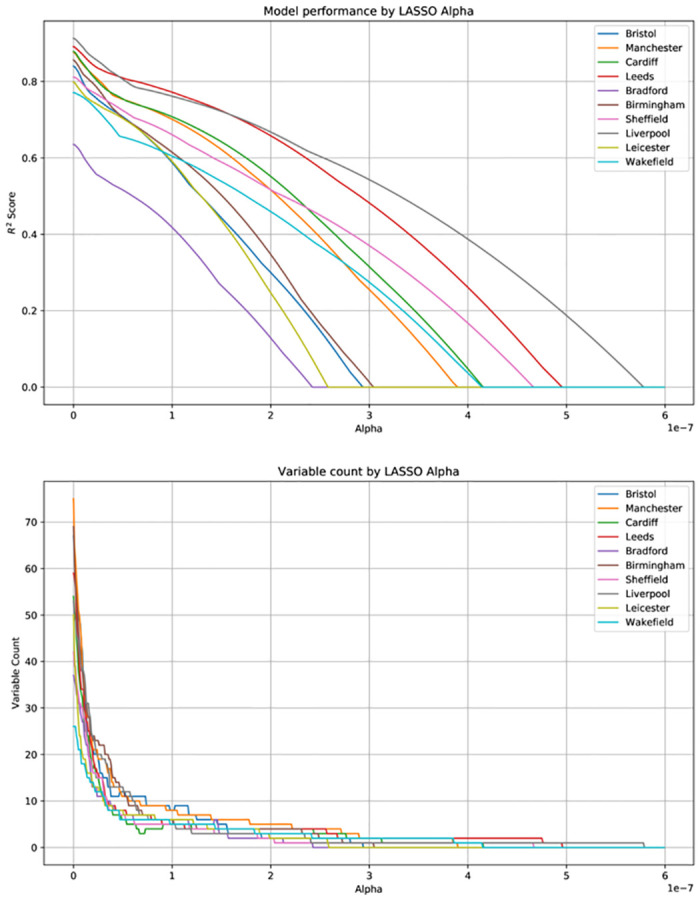
Model performance and variable count by LASSOα value, all cities.